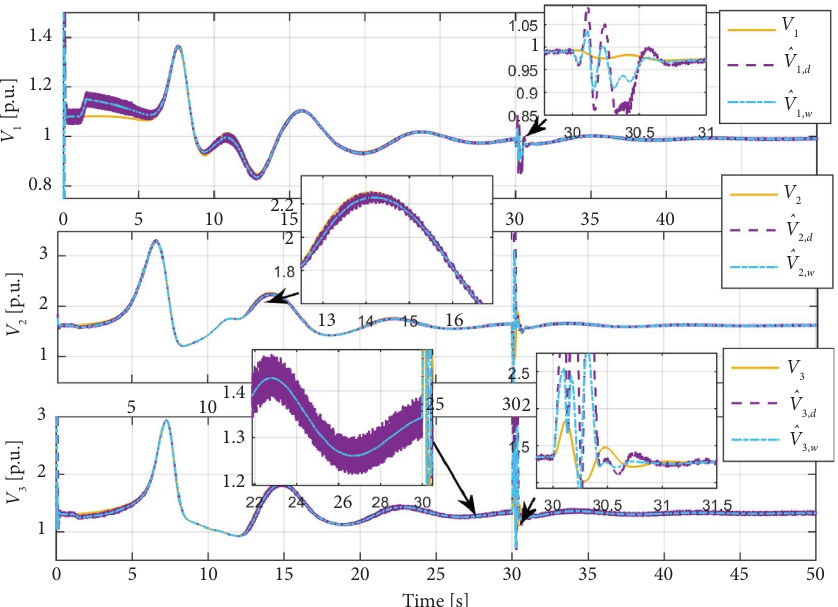
Figure 8: Estimation of voltage magnitudes through the proposed L-D GE